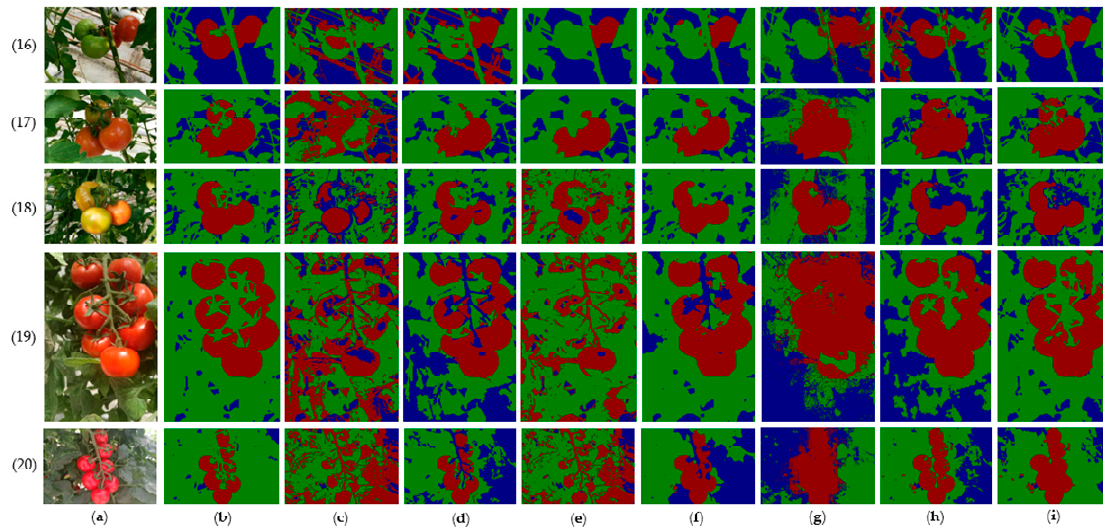
Figure 20. The result of different algorithms with close shots. Column ( a ) are original images. Column ( b ) are high quality ground-truth. Columns ( c – i ) are the results of several segmentation methods: quantum-behaved particle swarm optimization (QPSO), fuzzy c-means clustering (FCM), pulse coupled neural network based segmentation (PCNN), co-segmentation, the traditional latent Dirichlet allocation (LDA), self-adaptive latent Dirichlet allocation (SA-LDA), and self-adaptive iterative latent Dirichlet allocation (SAI-LDA), respectively.